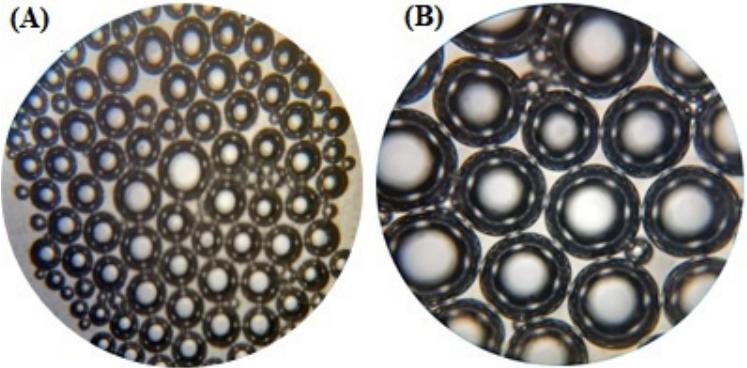
Figure 2. Optical microscopy of TE6 at 10× ( A ) and 40× ( B )